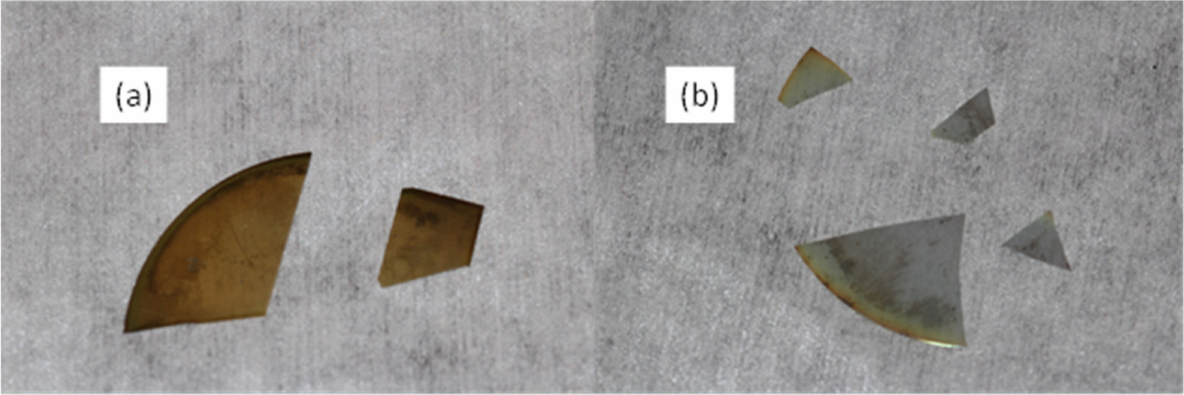
Figure 10. Photograph of ( a ) sample with high carbon and ( b ) sample with low carbon.